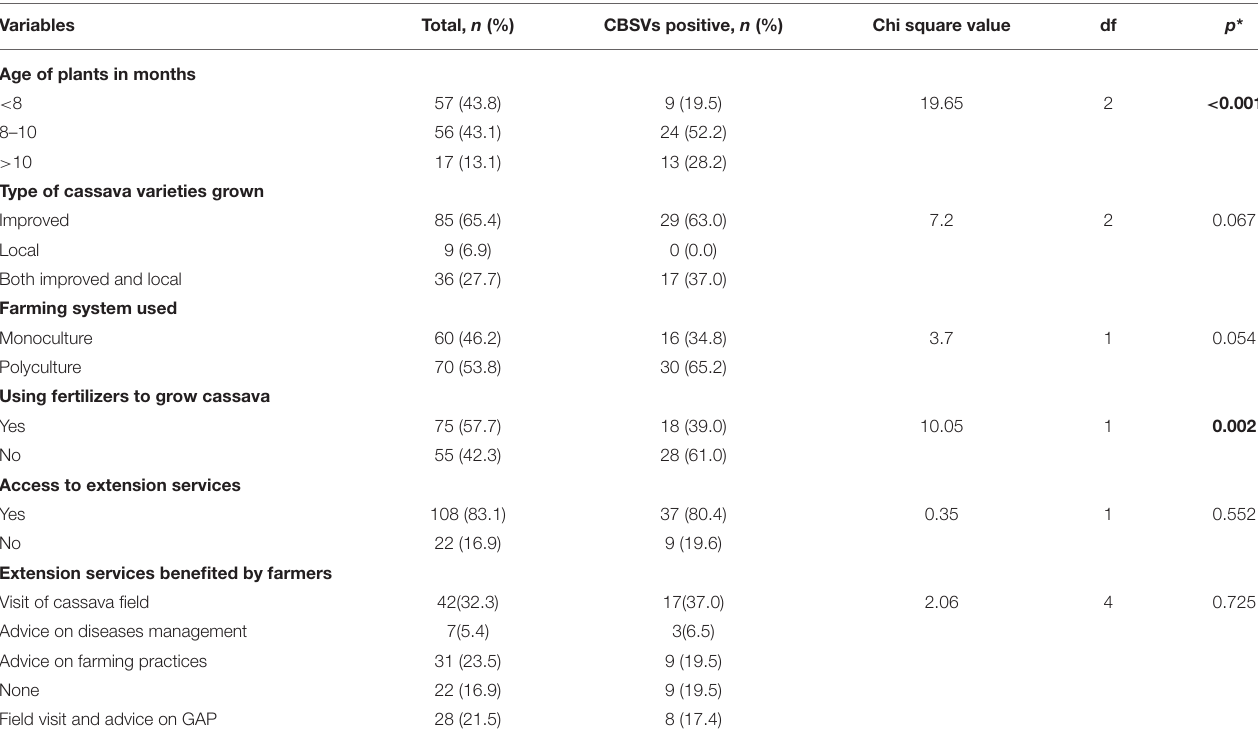
TABLE 3 | Impact of agronomic variables on cassava infection.